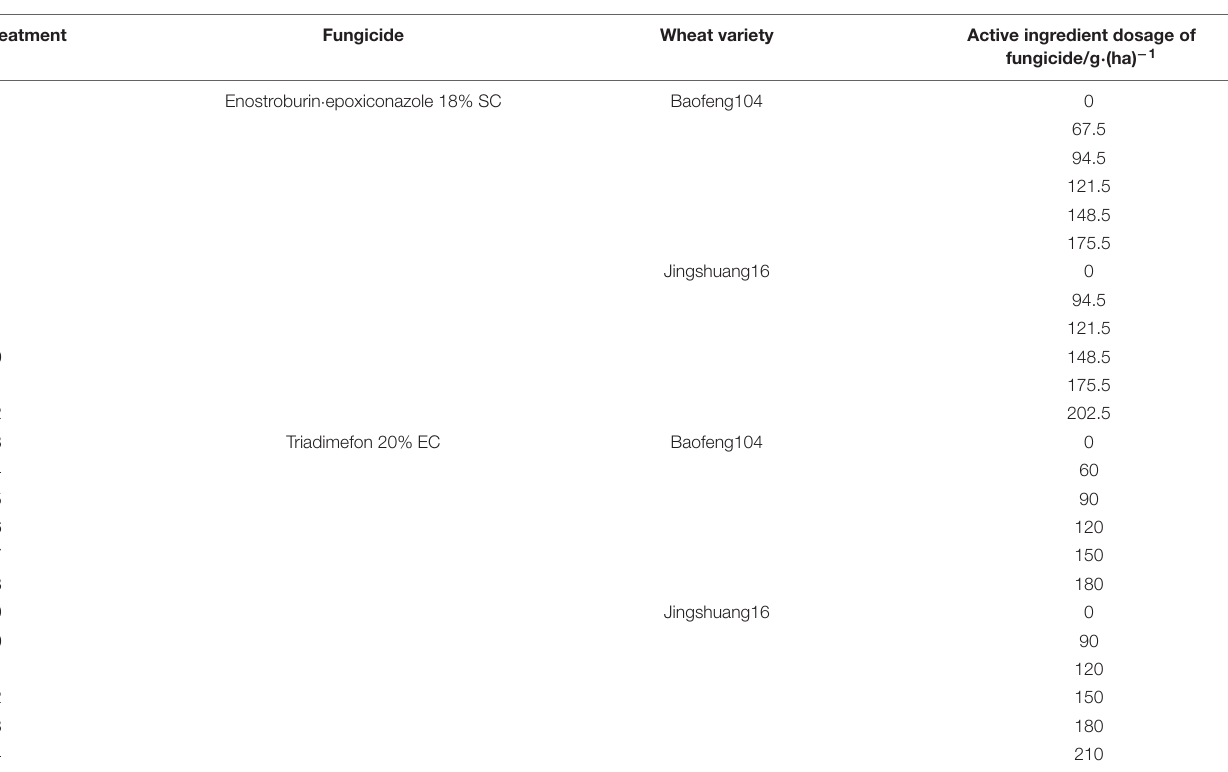
TABLE 1 | Treatments of the field experiments in this study.